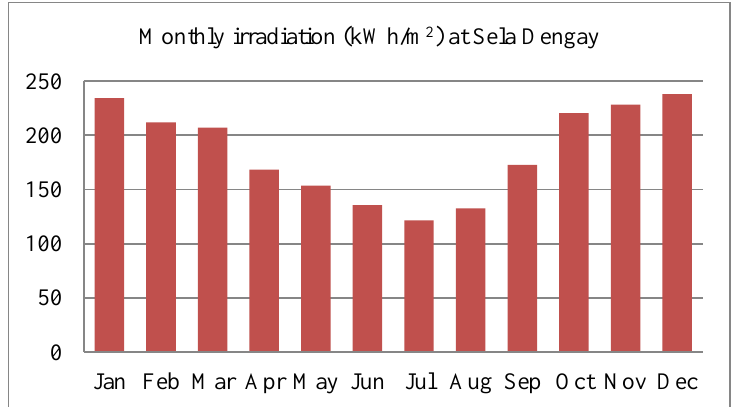
Figure 14. Solar radiation assessment of North Shewa zone at Sela Dengay.